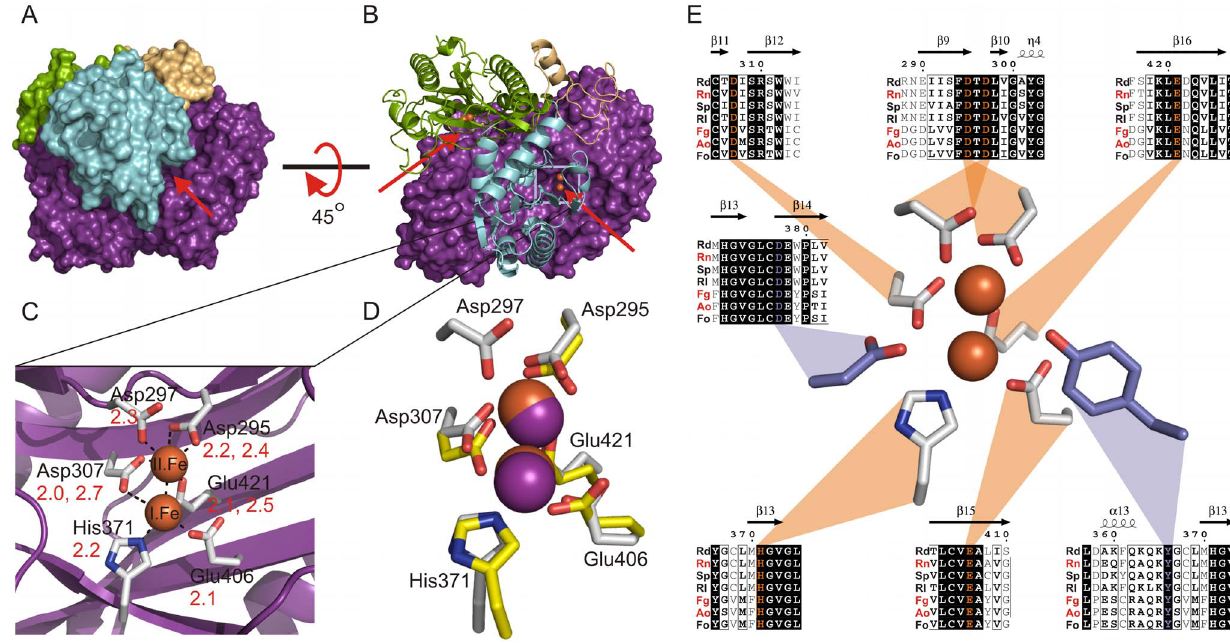
Figure 4. Dimerization shapes the tunnel active sites of Rd DddP with a binuclear iron metal center that is conserved in DddP lyases. ( a ) The dimer with one monomer in a cartoon plot presentation (beige, blue, green from the N-to the C-terminus), the second monomer in purple and the iron ions colored in orange. ( b ) The entrance to the two active sites and their path is indicated by the red arrows. ( c ) The metal binding site of Rd DddP with the two iron ions in orange and the conserved metal coordinating residues in grey. The distances between residues and metal ions, in angstroms, are indicated in red. ( d ) Comparison of the Rd DddP metal binding site (grey, iron ions as orange spheres) with the metal binding site of the methionine aminopeptidase (1MAT), (yellow sticks, cobalt ions as purple spheres). (e) Conservation of metal binding site and the putative catalytic residues in diverse DddP lyases from marine bacteria and fungi. Rd: Roseobacter denitrificans OCh 114, Rn: Roseovarius nubinhibens ISM, Sp: Silicibacter pomeroyi DSS-3, Rl: Roseobacter litoralis Och 149, Fg: Fusarium graminearum cc19, Ao: Aspergillus oryzae RIB40. Fc: Fusarium culmorum . Abbreviations in red indicate functionally characterized DddP lyases based on Todd et al . 2009. (notably here only a subset of DddP lyases is shown and the residues for metal binding and proposed catalysis are invariant in all DddP lyases presented in Todd et al . 2009). The alignment was prepared with ClustalW.